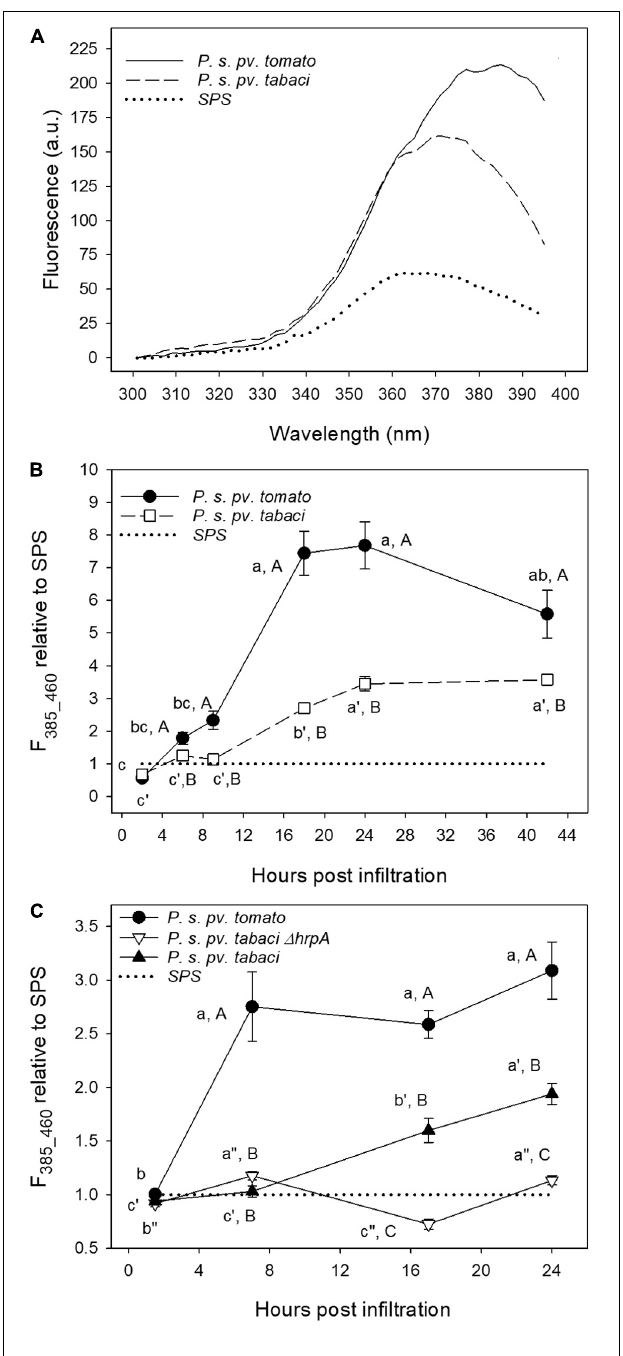
FIGURE 9 | The fluorescence excitation spectra of tobacco leaf disks measured at 24 hpi (A) , and time evolution of the 385 nm fluorescence excitation band (emission at 460 nm, F 385_460 ) (B,C) . The leaf disks were separately infiltrated with P. syringae pv. tabaci ATCC11528, its (cid:49) hrpA mutant, P. syringae pv. tomato , and with SPS as negative control. Each point is the mean ( ± SE) of leaf disks ( n = 24–45) from three different leaves of three different plants. The average excitation spectrum in planta on attached leaves was subtracted from the leaf disks spectra. In (B,C) , the values marked by a different lower case letter and primed or double-primed letter for the same treatment, and by an upper case letter for each time are significantly different ( p < 0.05) according to the Holm–Sidak